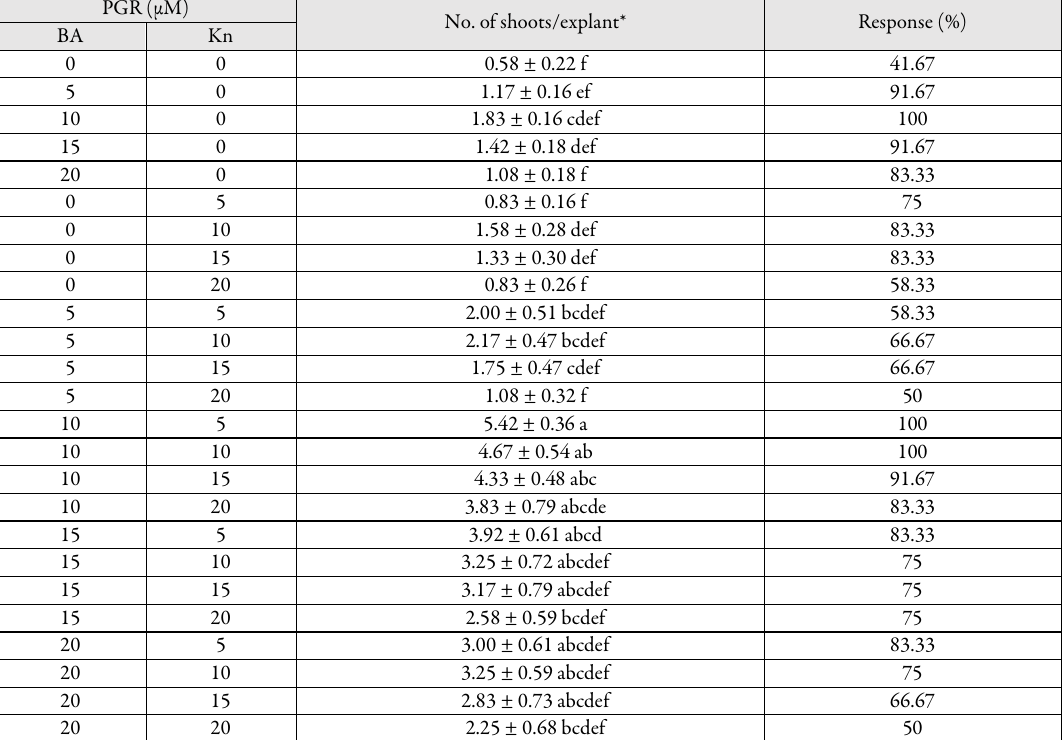
*Values represents mean ± SE. Means (n = 12) were subjected to ANOVA and means followed by same letter are not significantly different (p ≤ 0.05) according to Tukey’s